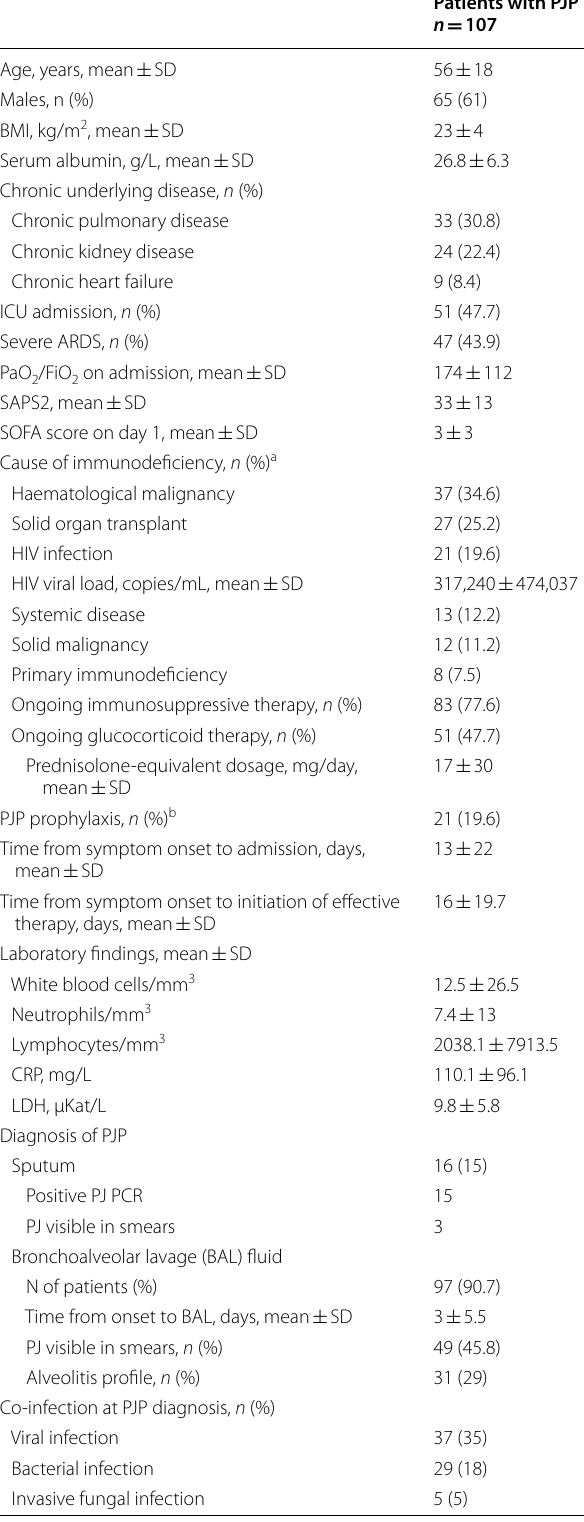
Table 1 Demographic characteristics of the 107 patients with Pneumocystis jirovecii pneumonia